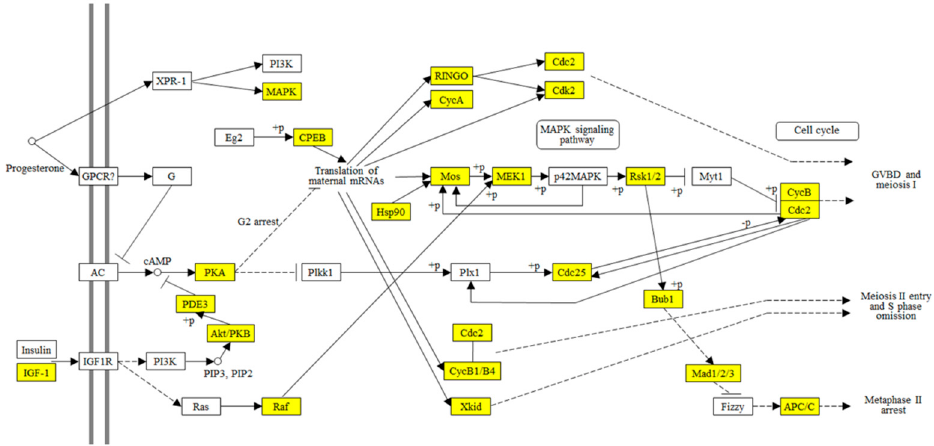
Figure 6. Mapping analysis of progesterone-mediated oocyte maturation pathway. Yellows represent the transcripts of C. chuxiongica females mapped to the Xenopus progesterone-mediated oocyte maturation pathway (KEGG id: map04914).